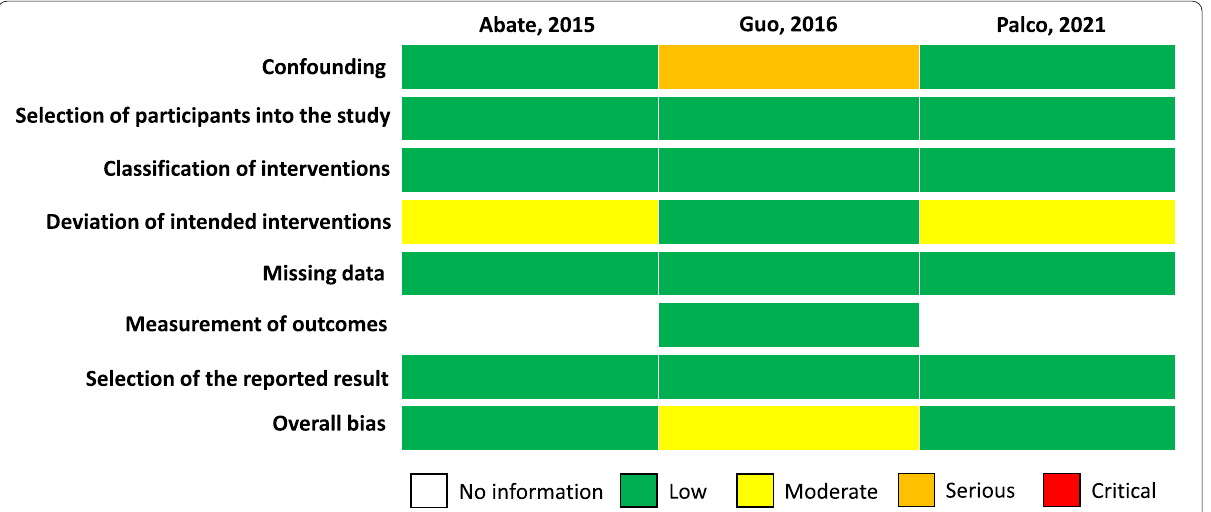
Fig. 3 Detailing the quality assessment of the 3 cohort studies using the ROBINS-I tool. Green: Low risk, Yellow: Moderate risk, Orange: Serious risk, Red: Critical risk